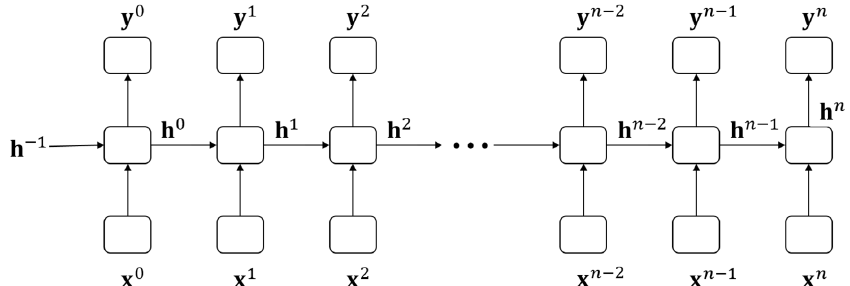
Figure 2. Recurrent neural network structure.